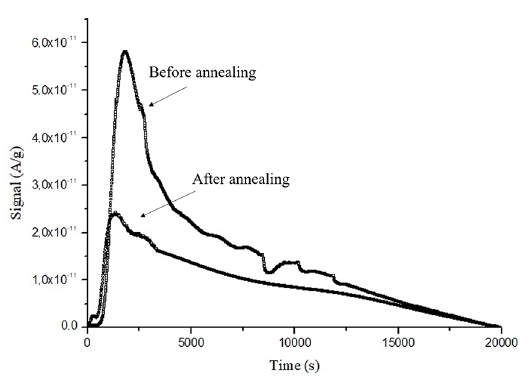
Figure 5. TDS of Zr-0.9Nb-0.1Mn alloy before and after annealing. The isothermal TDS spectrum of the hydrogenated annealed alloys presented one peak as indicated in Figure 6.